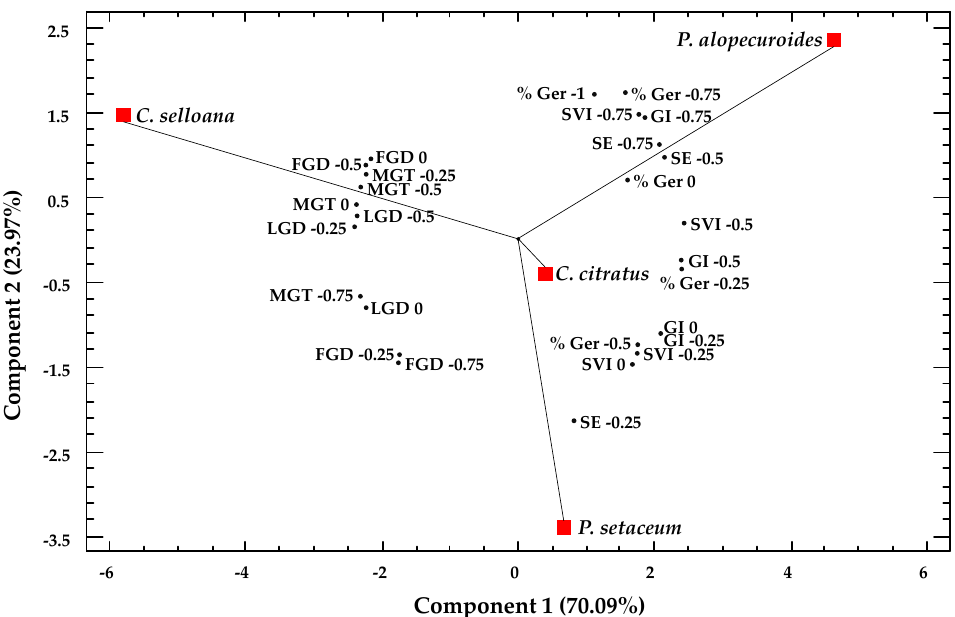
Figure 7. Principal Component Analysis of germination data. Loading and scatter plots of the PCA scores were conducted with germination and seedling’s traits of the species C. citratus , C. selloana , P. alopecuroides and P. setaceum . Abbreviations: % Ger, final percentage of germination; MGT, mean germination time; FGD, first germination day; LGD, last germination day; SE, speed of emergence; GI, germination index; SVI, seedling vigour